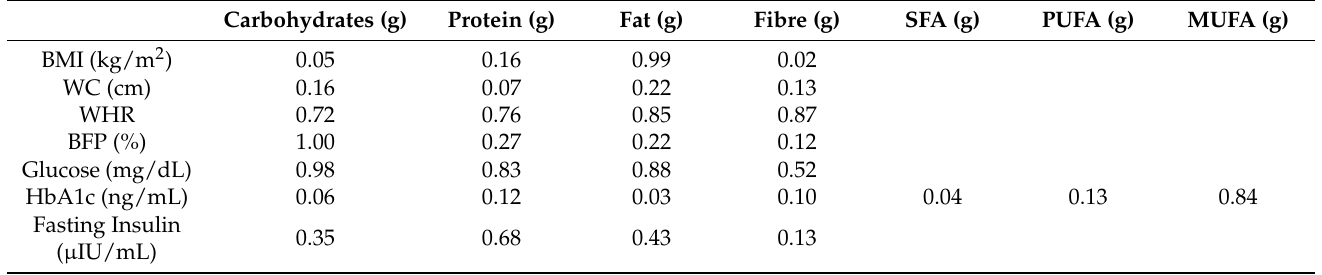
Table 2. Interaction between dietary factors and vitamin D-GRS on clinical and metabolic